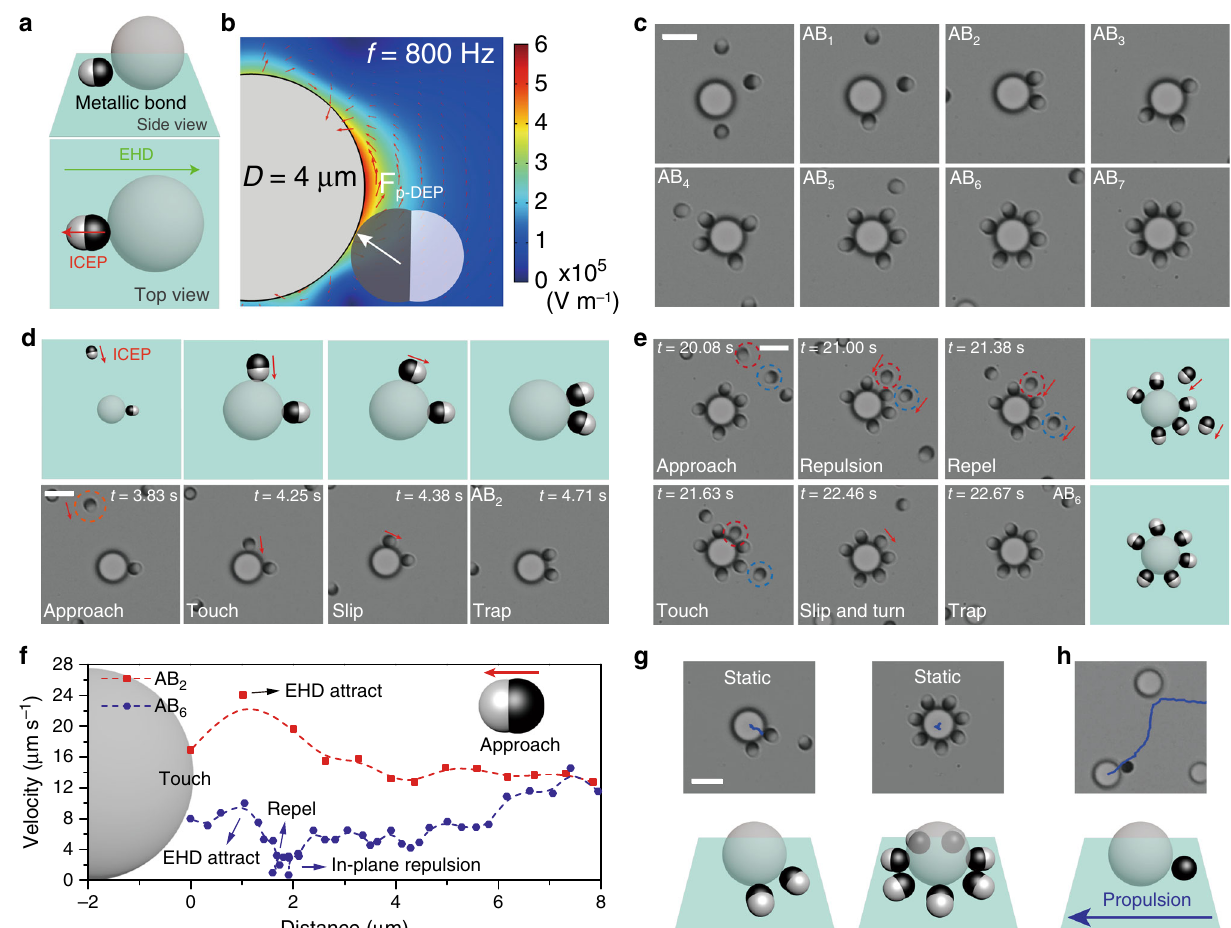
Fig. 4 Colloidal molecules with metallic bonds. a Cartoon showing the side and top view of an AB colloidal molecule with the metallic bond, by patchy particle P 3 and the 4- µ m central sphere. b Finite-element analysis showing the p-DEP attraction between the metallic lobe and the sphere stabilizes the bond. Red arrows represent the direction of electric fi eld lines. Color bar: electric fi eld strength. c Optical microscope images of colloidal molecules with metallic bonds (AB 1 to AB 7 ). d The formation kinetics of a metallic bond, showing that P 3 approaches and touches the big sphere with its dielectric lobe, slips along the rim of central sphere and fi nally turn to bind the sphere with the metallic lobe. e In forming high-order colloidal molecules, P 3 overcomes long-range repulsion from bound ligand particles and makes space, before it lands with the dielectric lobe and binds to the metallic lobe. f Plot showing the velocity of patchy particles during the formation of AB 2 (red square) and AB 6 (blue circle) colloidal molecules, revealing the in fl uence of EHD and dipolar repulsion. g Colloidal molecules with metallic bonds show weak propulsion ability; h Replacing patchy particles with gold spheres enables propulsion of the assembled colloidal molecules. Scale bar: 4 μ m.